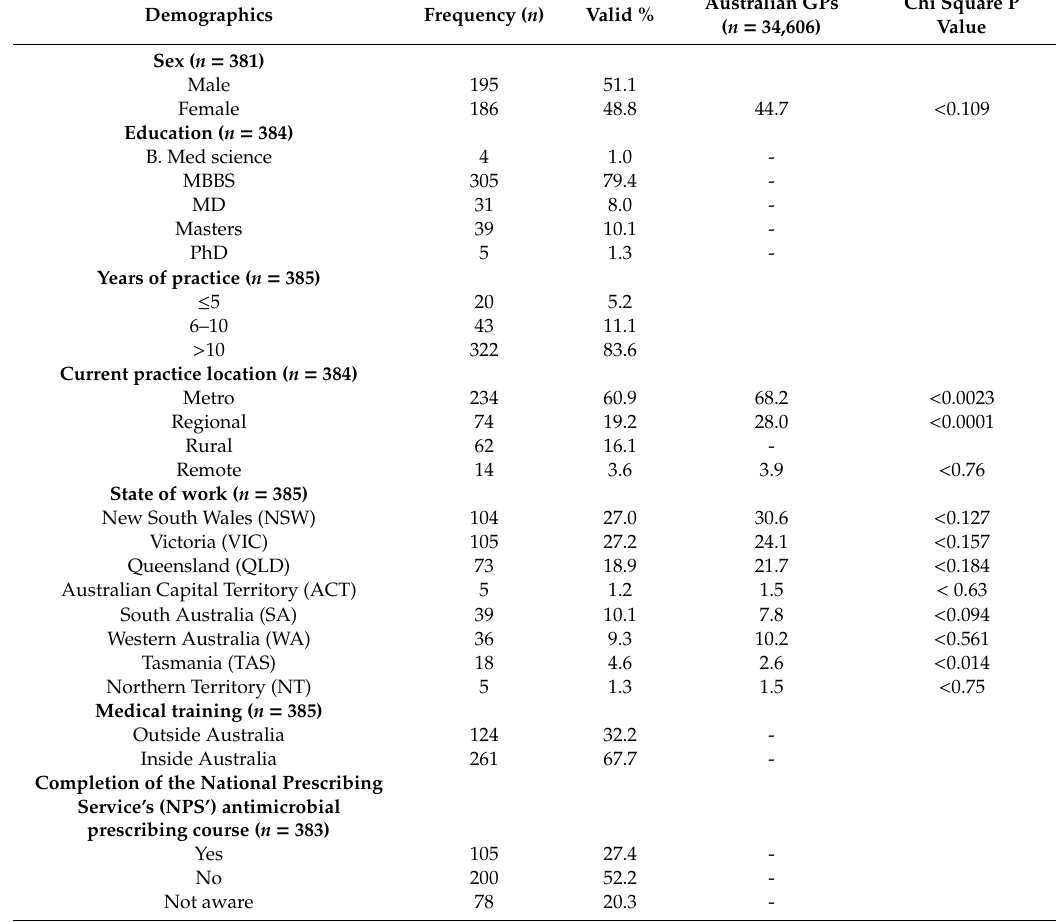
Table 1. Demographics of respondent general practitioners